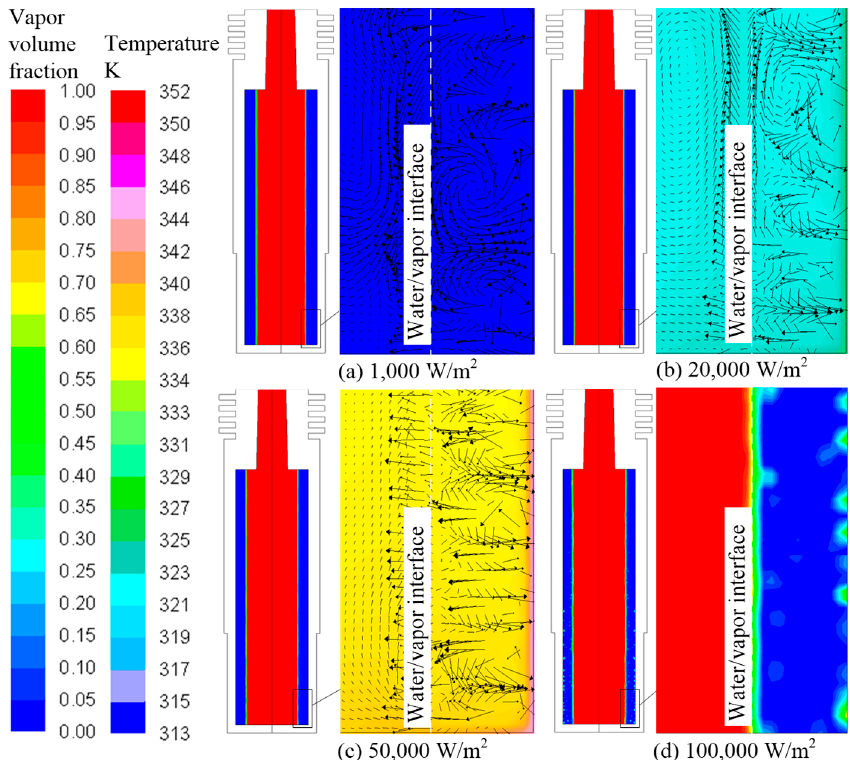
Figure 3. Heat transfer performance under different input heat flux.